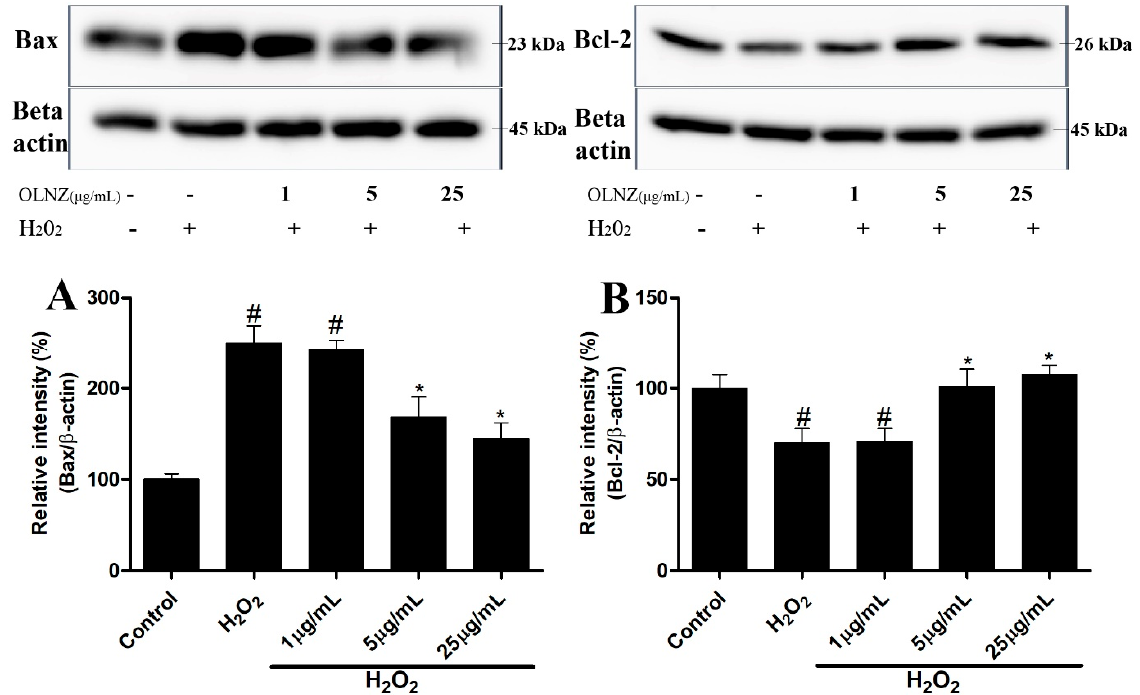
Figure 13. Protective role of OLNZ in H 2 O 2 -mediated apoptosis and on Bax and Bcl proteins in SH- SY5Y cells. The expression (%) of ( A ) Bax protein decreased and ( B ) Bcl-2 increased after pretreatment of SH-SY5Y cells with OLNZ in comparison with H 2 O 2 -mediated neurotoxicity in SH-SY5Y cells. All data are presented as the mean ± SEM, and the experiment was repeated three times. (#) compared to the control and (*) compared to H 2 O 2 , p < 0.05.